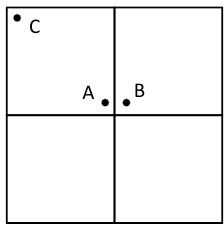
Figure 2. False result of Geohash Method